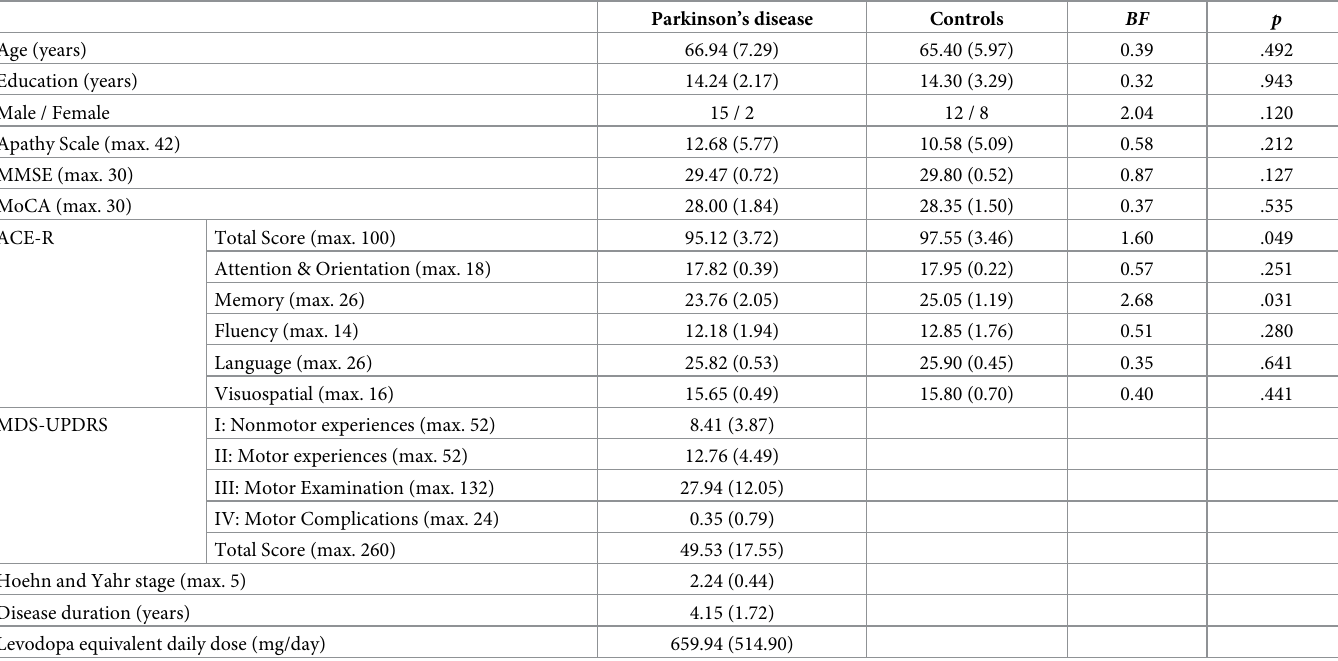
Table 1. Demographics and clinical characteristics of